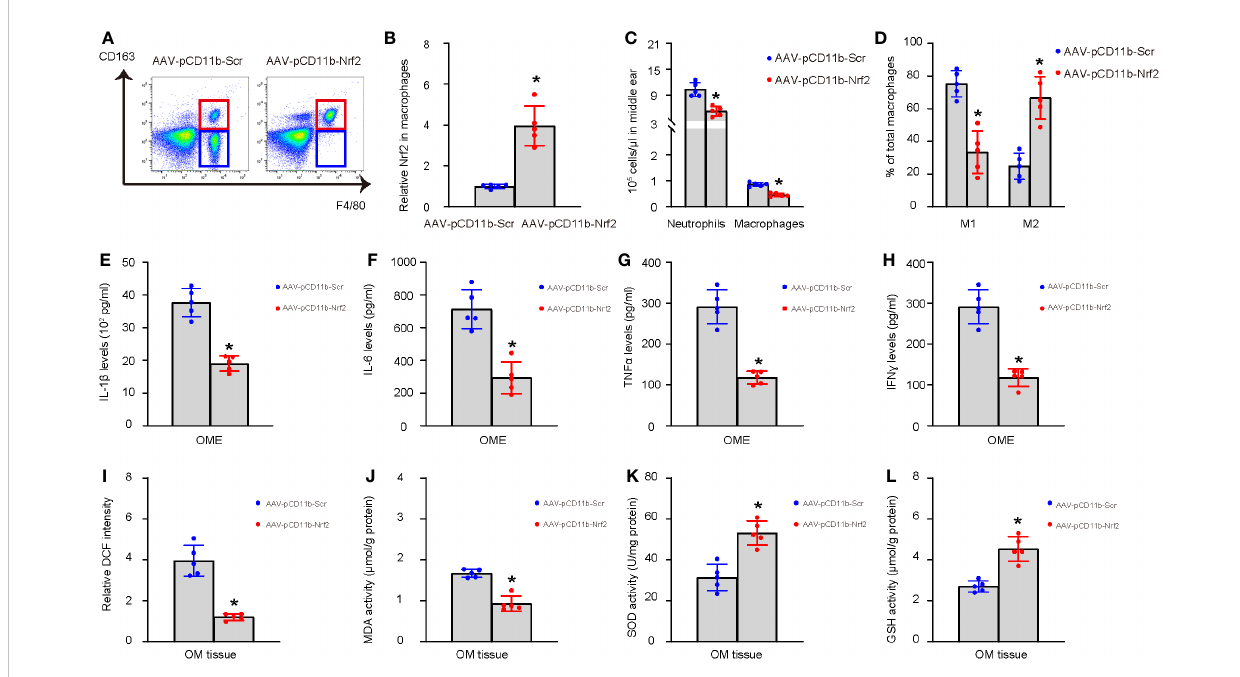
FIGURE 6 Correction of Nrf2 expression in macrophages prevents transition from AOM to COM. Immediate myringotomy-assisted injection of AAV-pCD11b- Nrf2 or control AAV-pCD11b-Scr into the middle ear cavity of selective LPS-treated mice with low Nrf2 levels in OME-macrophages at day 7 after LPS administration was performed. Afterwards, the mice were maintained for another 3 weeks (4 weeks after LPS) and examined again for the recruitment of in fl ammatory cells and macrophage polarization in OME, the levels of major pro-in fl ammatory cytokines IL-1 b , IL-6, TNF a , and IFN ɣ in OME, and the levels of ROS, MDA, GSH, and SOD in the middle ear mucosae tissue. Analysis was done at 4 weeks after LPS or 3 weeks after viral intervention. OME was collected using myringotomy. (A) F4/80+ macrophages were analyzed by fl ow cytometry, shown by representative fl ow charts. (B) ELISA for Nrf2 in OME-macrophages. The relative Nrf2 levels in OME-macrophages from mice transduced with AAV-pCD11b-Scr were used as the reference point (=1), and the relative Nrf2 levels in OME-macrophages from mice transduced with AAV-pCD11b-Nrf2 were calculated in comparison to this reference. (C) Number of neutrophils and macrophages in OME. (D) Quanti fi cation of macrophage polarization (CD163) by fl ow cytometry. (E – H) ELISA for IL-1 b (E) , IL-6 (F) , TNF a (G) , and IFN ɣ (H) in OME. (I – L) The levels of ROS (I) , MDA (J) , SOD (K) and GSH (L) in the middle ear mucosae tissue.